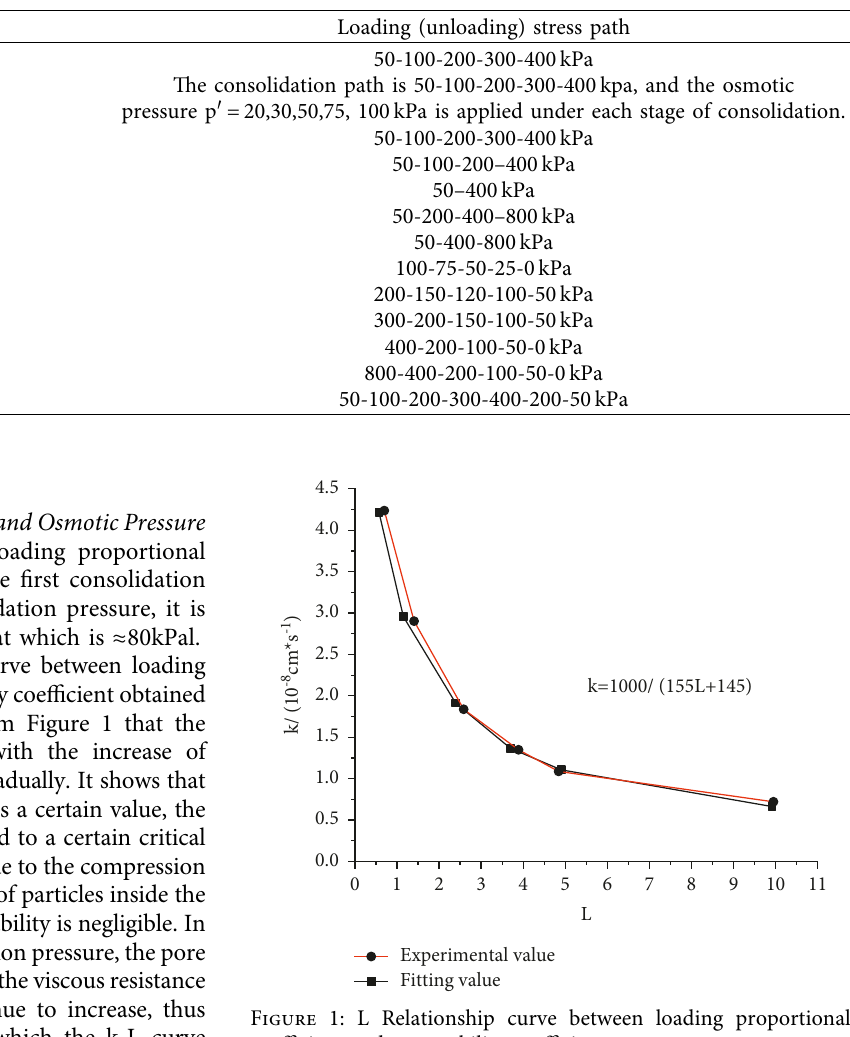
Table 2: Test scheme of permeability characteristics.